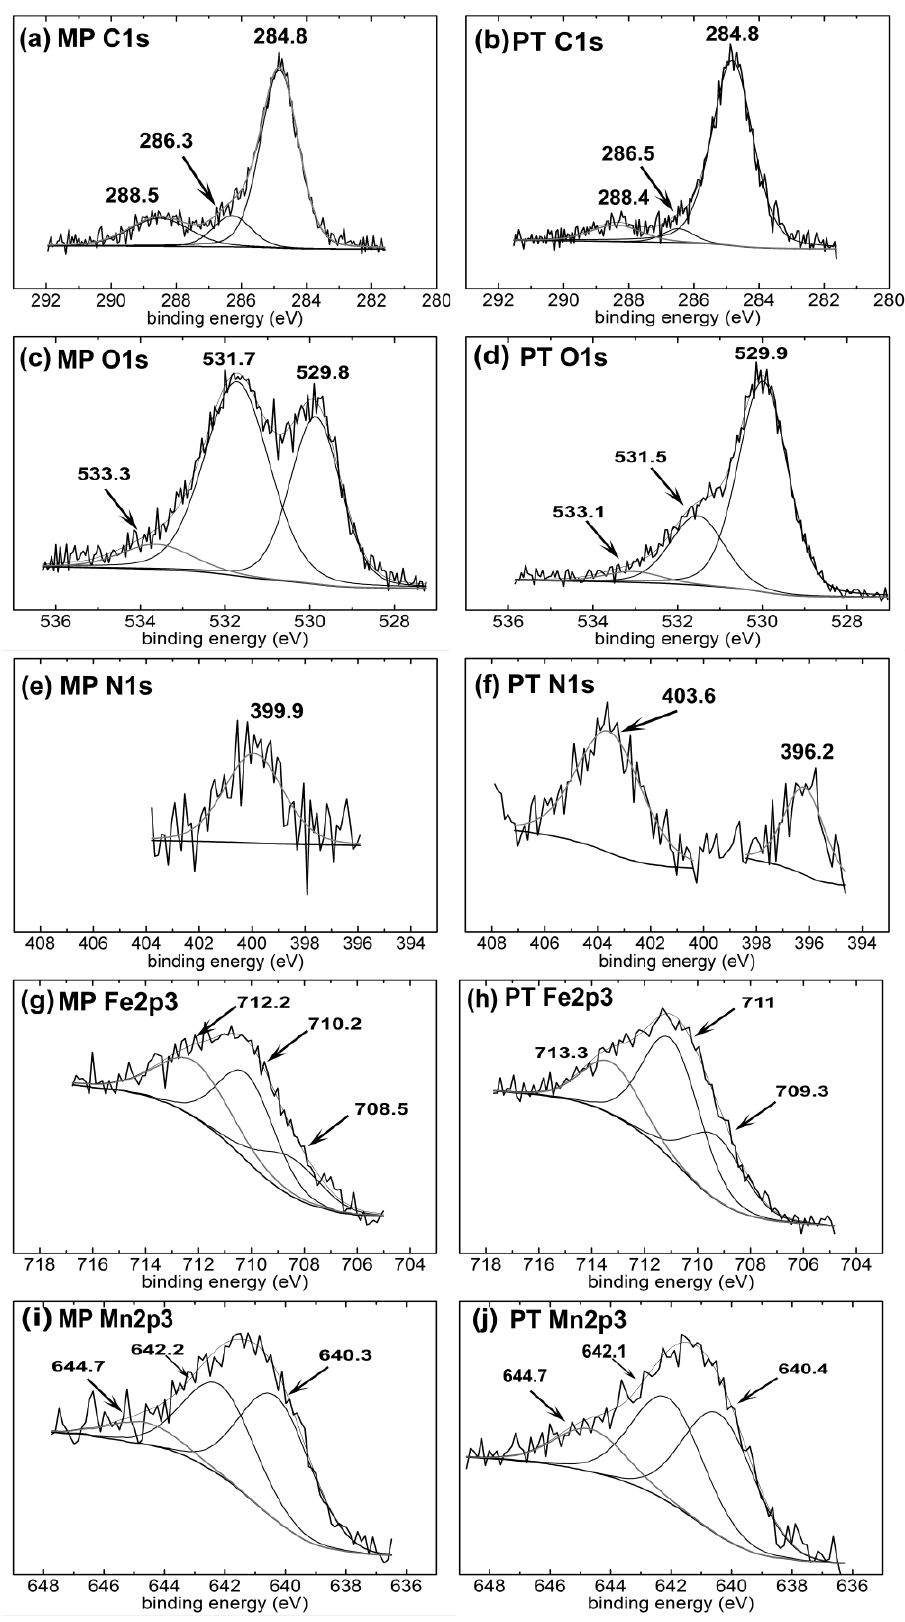
Figure 3. XPS high resolution deconvolutions for MP ( a ) C1s, ( c ) O1s, ( e ) N1s, ( g ) Fe2p3, ( i ) Mn2p3; and for PT ( b ) C1s, ( d ) O1s, ( f ) N1s, ( h ) Fe2p3 and ( j )